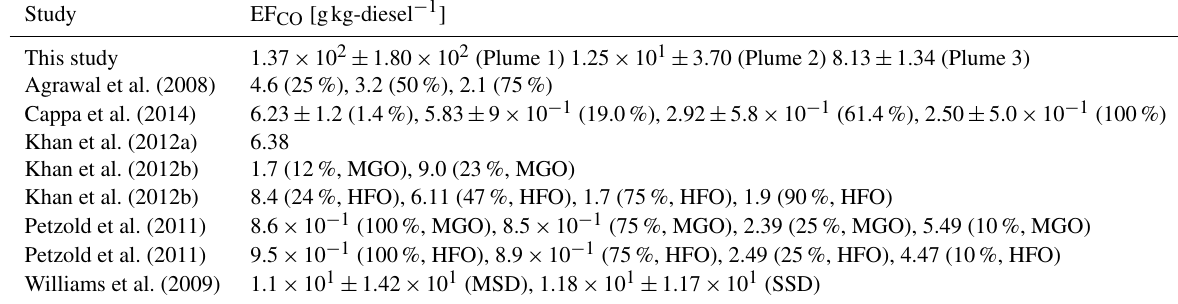
Table 4. Emission factors for CO; numbers in brackets indicate engine load (%), fuel type (HFO: heavy fuel oil with high sulfur content, and MGO: marine gas oil with low sulfur content), or vessel class based on gross metric tonnage (HSD: high speed diesel < 5000t, MSD: medium speed diesel 5000–30000t, or SSD: slow speed diesel > 50000t); the uncertainty is computed using the orthogonal distance regression (ODR) method.